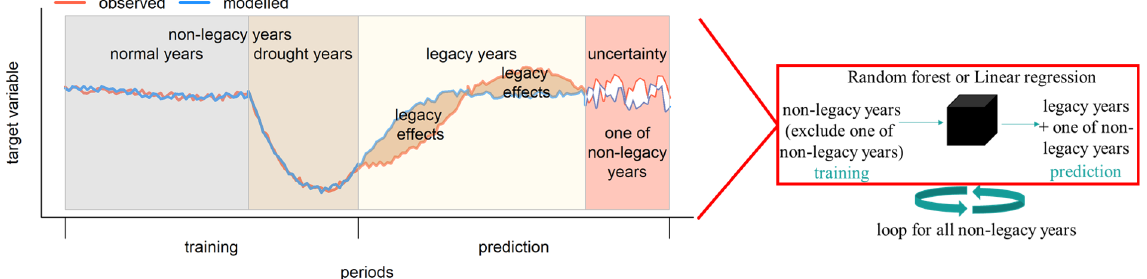
Figure 1. Conceptual diagram of quantification of legacy effects. A random forest (RF) model (or linear regression, represented by the black cube on the right) was used to determine the relationship between the target variable (GPP anom or RI) and hydrometeorological conditions using a training dataset that excludes data in all legacy years and one of the non-legacy years for each loop. The legacy effects could be quantified as the residuals between observed (red line) and modelled (blue line) target variable (i.e. GPP anom , RI,...) in legacy years. And the residuals between observed and modelled target variable (i.e. GPP anom , RI,...) in all non-legacy years from all loops indicated RF model uncertainties using a leave-one-out approach (see the